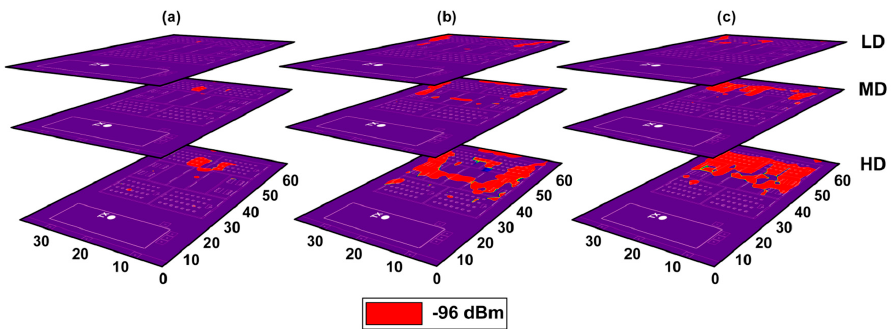
Figure 8. Fulfilment of the sensitivity for the central node potential placement, where sensitivity threshold is − 96 dBm. ( a ) First floor; ( b ) Second floor; ( c ) Third floor.